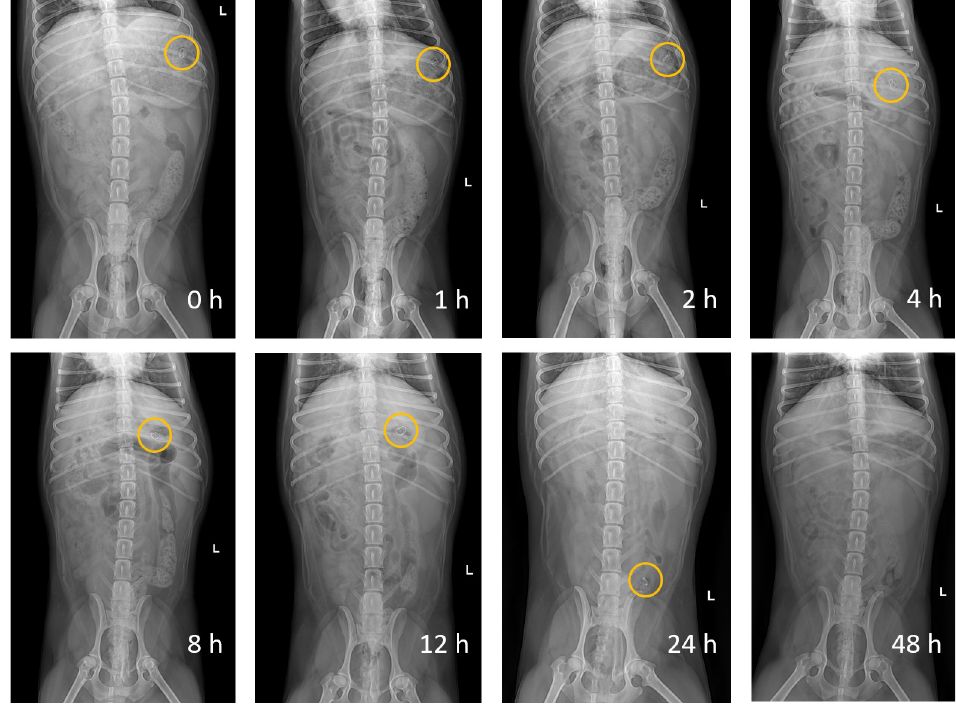
Fig 4. Abdominal X-ray images of the gastroretentive (GR) system in a Beagle dog. Abdominal X-ray images indicating the positions of the GR system in the gastrointestinal tract of a Beagle dog following oral administration for 24 h. The circles represent the GR system in the Beagle